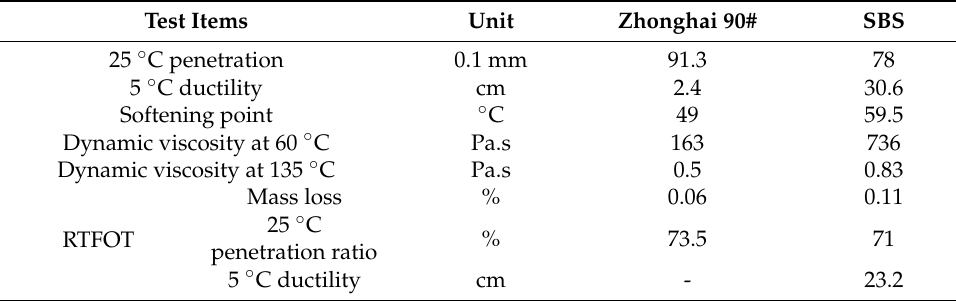
Table 1. Physical properties of used asphalt.